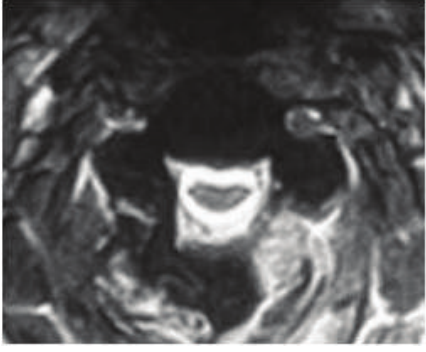
Figure 6: Post-laminoplasty MRI showing the open hinge and space available for the cord created by the